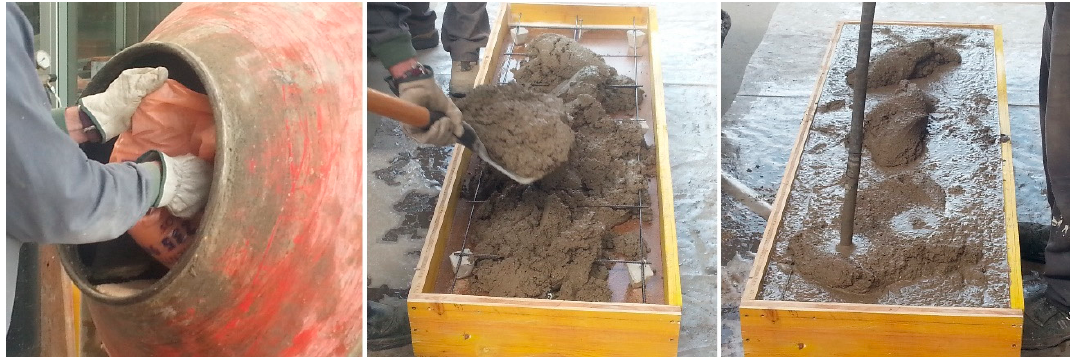
Figure 6. Manufacture mortar ( left ), placing of the mortar ( center ) and mortar compactation ( right ).